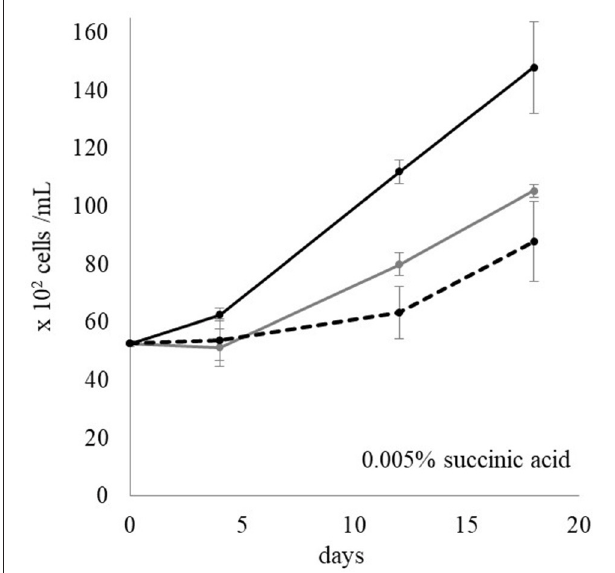
FIGURE 6 | L. polyedrum growth in media with DG893 supernatant, mutant supernatant, and without bacterial supernatant. The black lines, gray lines, and dotted lines represent L. polyedrum growth in media with added DG893 supernatant, with added VF null mutant supernatant, and without any bacterial supernatant,